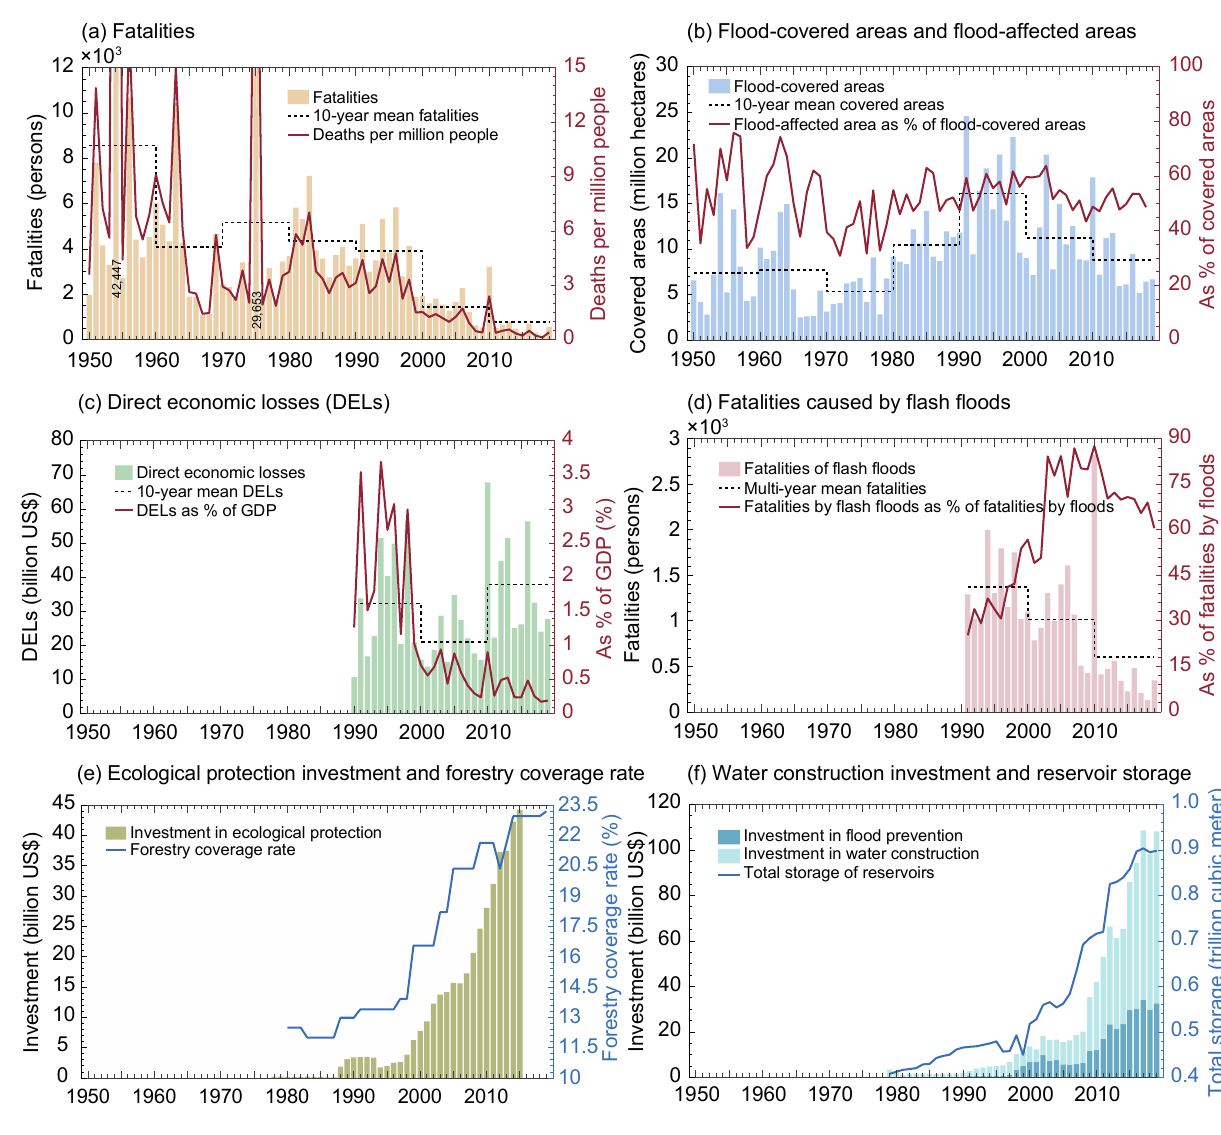
Figure 2. Changes in direct damages ( a – d ) caused by flood and flood-related DRR investment (( e , f ), adapted from refs. [14,26]) in China during 1950–2019 (missing numbers in some years represent lacking source data). All economic numbers are adjusted at the 2019 price level.